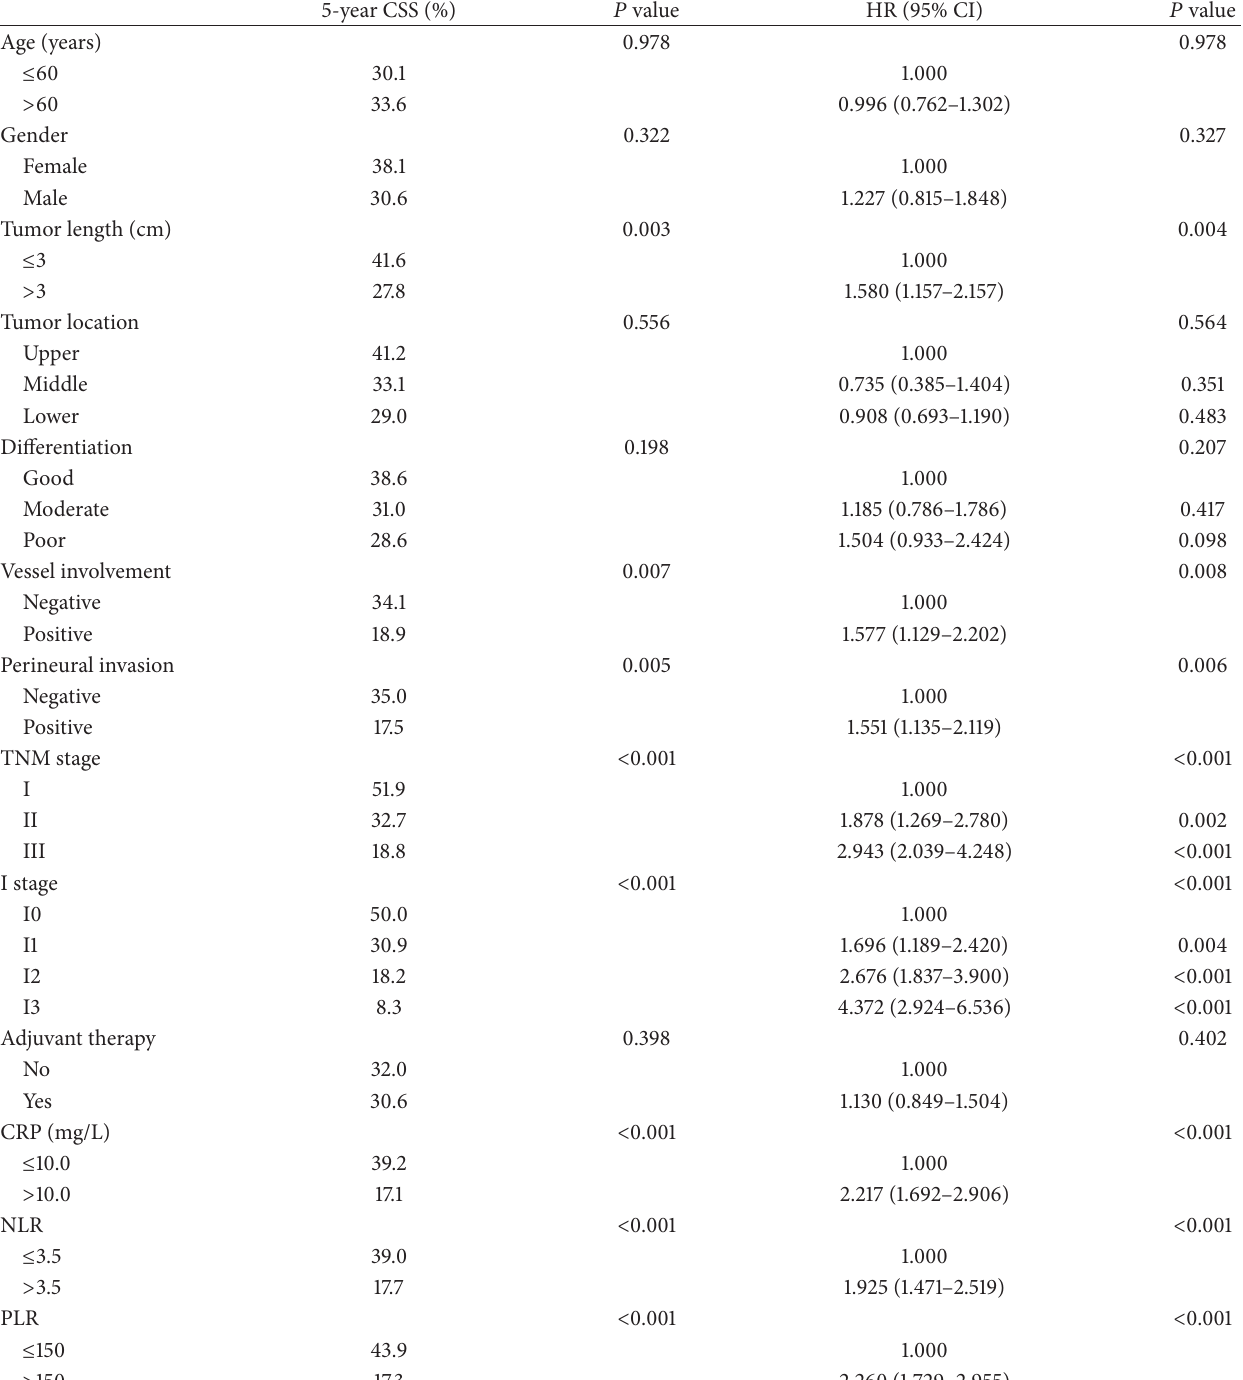
Table 3: Univariate analyses for patients with